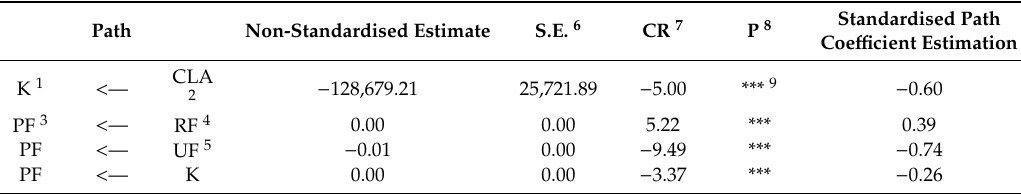
Figure 4. SEM of the characteristic parameters of preferential flow and typical characteristic values of influencing factors (e represents the errors). Table 7. Covariance results of SEM